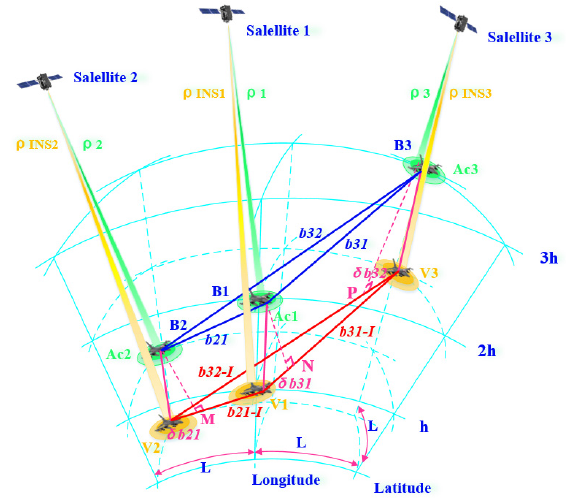
Figure 4. Schematic diagram of collaborative navigation in the DWAPC-TSM system.